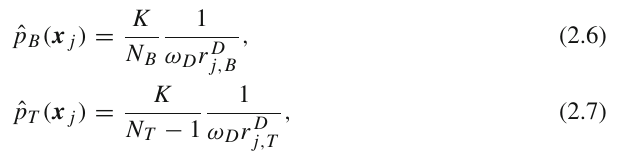
Fig. 1 Schematic view of the proposed method to compute the p value of the null hypothesis that the two samples are drawn from the same probability density K